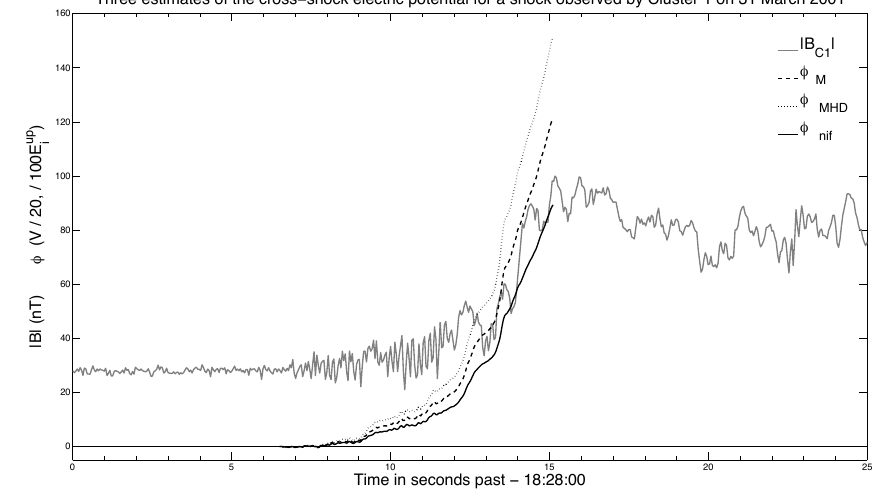
Fig. 4. A shock crossing made by the Cluster 1 spacecraft around 18:28 on 31 March 2001. The grey line shows the magnetic field magnitude measured by the Cluster 1 FGM instrument during the bow shock crossing. The dotted black line is the estimate based on the assumption that the electric field along B is zero. The black dashed line shown the estimate based on only the 2 measured electric field components. The black solid line represents the potential estimate by evaluating the missing electric field component based on the NIF condition ( E NIF · B ⊥ = 0).